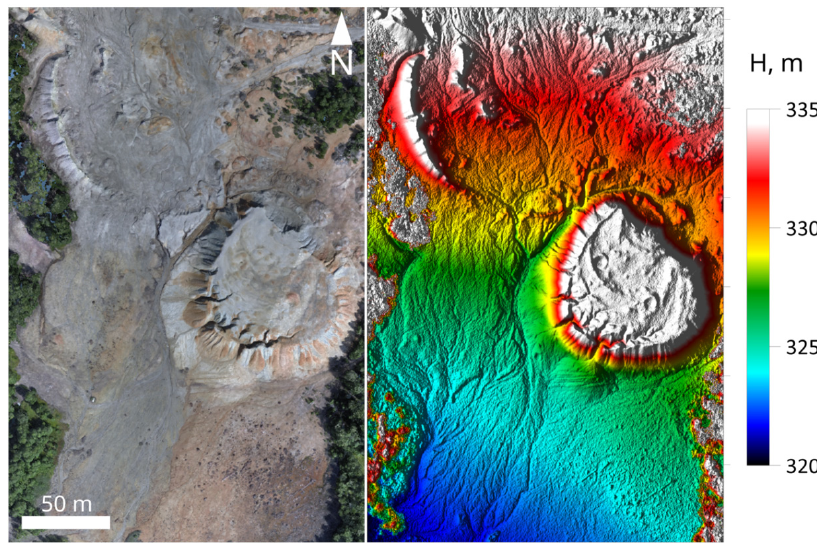
Figure 10. Fragment of the orthophotomap and digital elevation model.